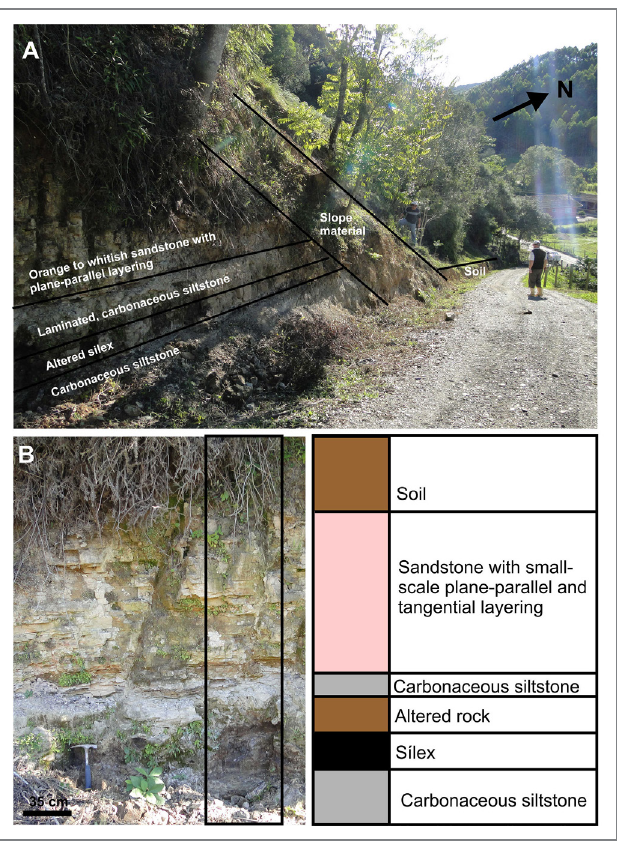
FIGURE 2 – A) Outcrop AM-01, in Ribeirão Cipriano, Salete Municipality; B) Detailed profile of point